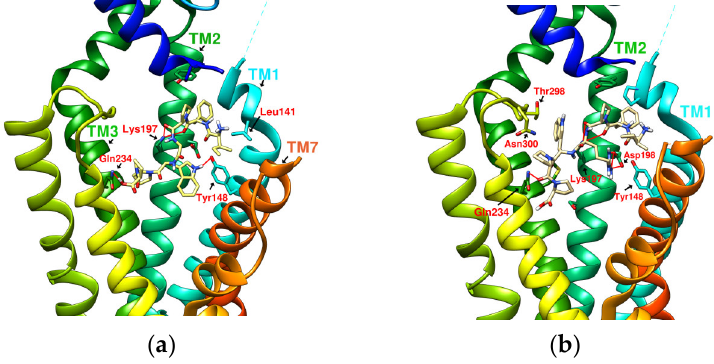
Figure 12. ( a ) IFPGWPP N10 (−10.4 kcal/mol), ( b ) IFPRWPP N13 (−10.4 kcal/mol).